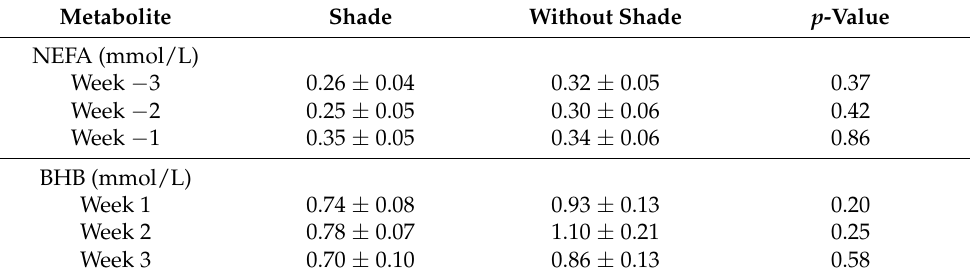
Table 4. Serum NEFA and BHB concentrations were observed in cows with access to shade ( n = 12) and without shade ( n = 11) in different weeks relative to calving (LSM ± SE). p -values are presented by prepartum and postpartum week, between